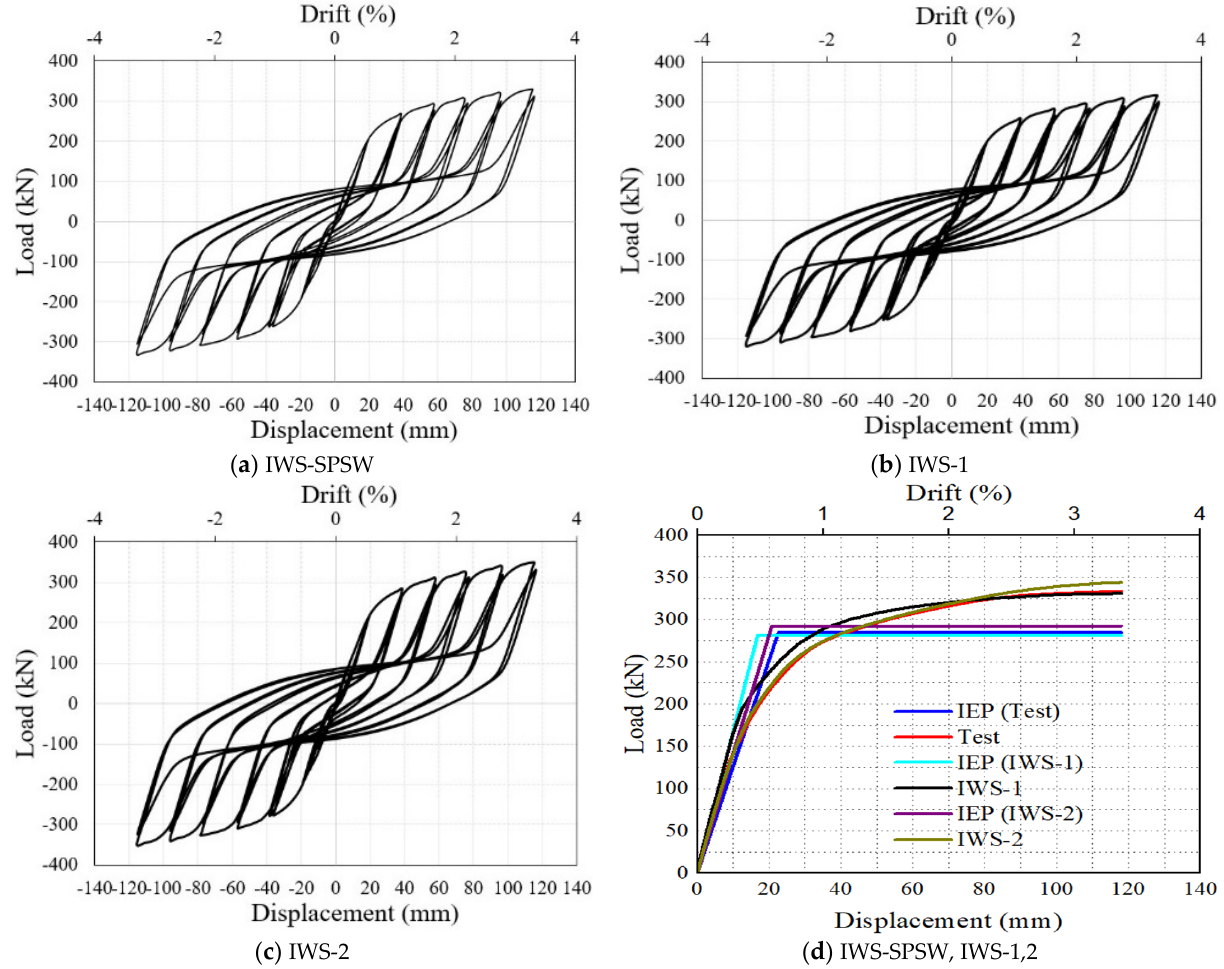
Figure 17. Hysteresis, pushover, and IEP response of the FE models.